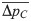
Average change in the frequency of cooperators, ΔpC¯, as a function of the frequency of cooperators, p
C, in (A) an asymmetric Donation Game and (B) asymmetric Snowdrift Games.The update rules are (A) imitation and (B) death-birth, and each process has for a selection intensity β = 0.01. In both figures, the network is a random regular graph of size N = 500 and degree k = 3. In (A), benefits and costs of cooperation vary across vertices according to a Gaussian distribution with mean 3.5, variance 1.0 for benefits and mean 0.5, variance 0.25 for costs. In (B), the benefit is b = 5.0 for all vertices, and the costs are either low, c
1 = 34/13, or high c
2 = 70/13, which actually recovers the payoff ranking of the Prisoner’s Dilemma because c
2 > b. The costs are the same for all vertices (c
1, blue and c
2, green) or mixed at equal proportions (red). (B) confirms that the average change in cooperators in the mixed Snowdrift Game/Prisoner’s Dilemma (red) may be obtained by averaging these changes for the Snowdrift Game (blue) and the Prisoner’s Dilemma (green). The small, systematic deviations between simulation data and analytical predictions (solid lines) are explained in Methods (where it is also shown that ΔpC¯ is linear in β for β ≪ 1).